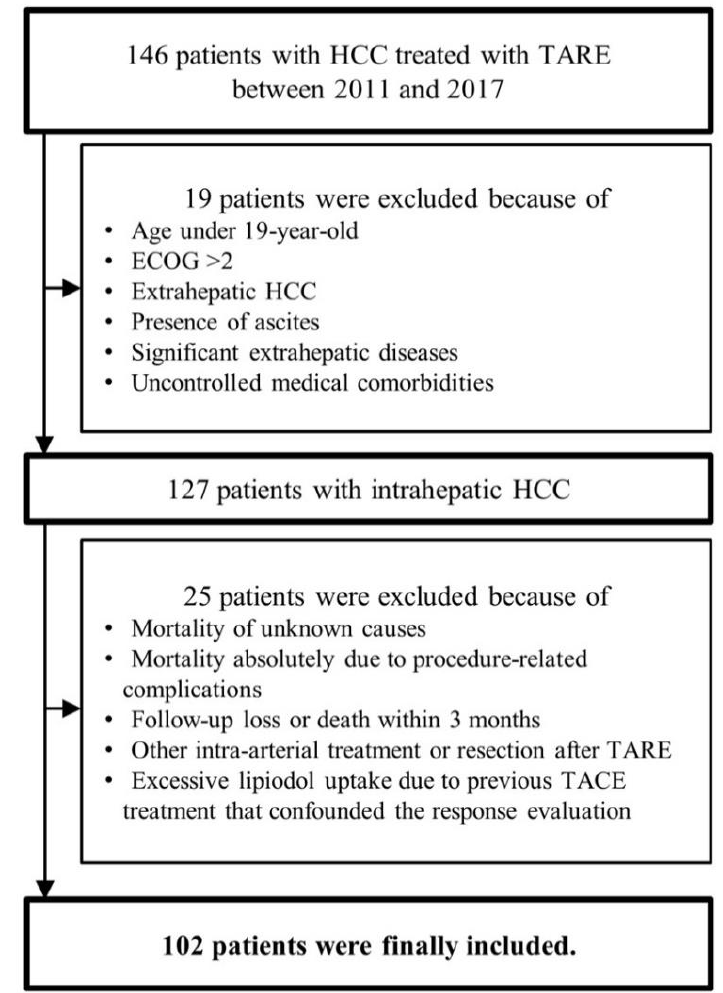
Figure 1. Flow of the study population selection. HCC, hepatocellular carcinoma; TARE, trans-arterial radioembolization; TACE, trans-arterial chemoembolization; ECOG, Eastern Cooperative Oncology Group.